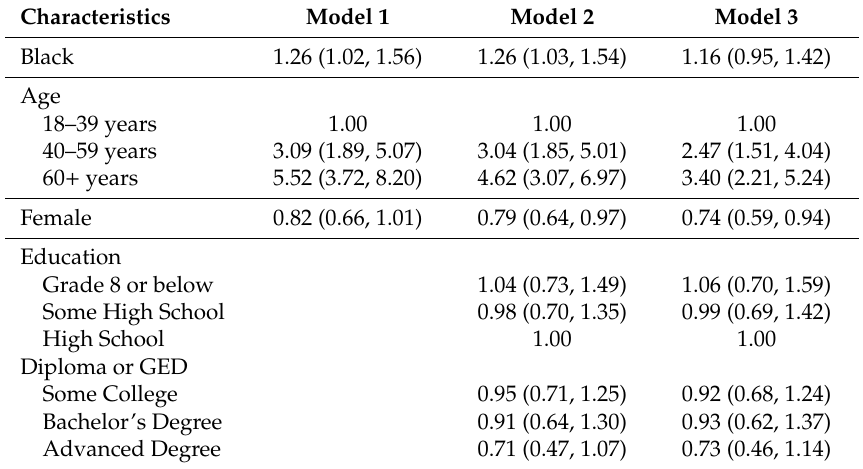
Table 2. Prevalence ratios and 95% confidence intervals of hypertension among Medical Expenditure Panel Survey respondents, age 18 years and older, living within gentrifying neighborhoods,